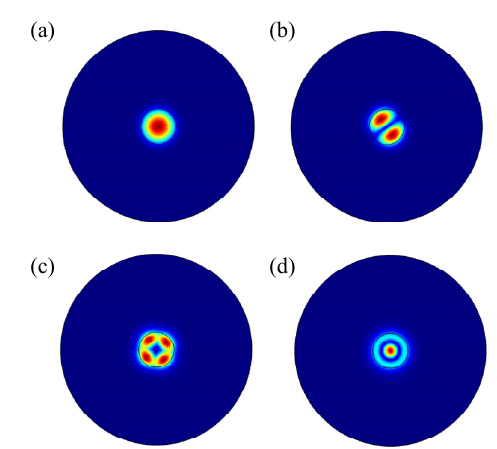
Fig. 2 Mode field distribution of the transmission